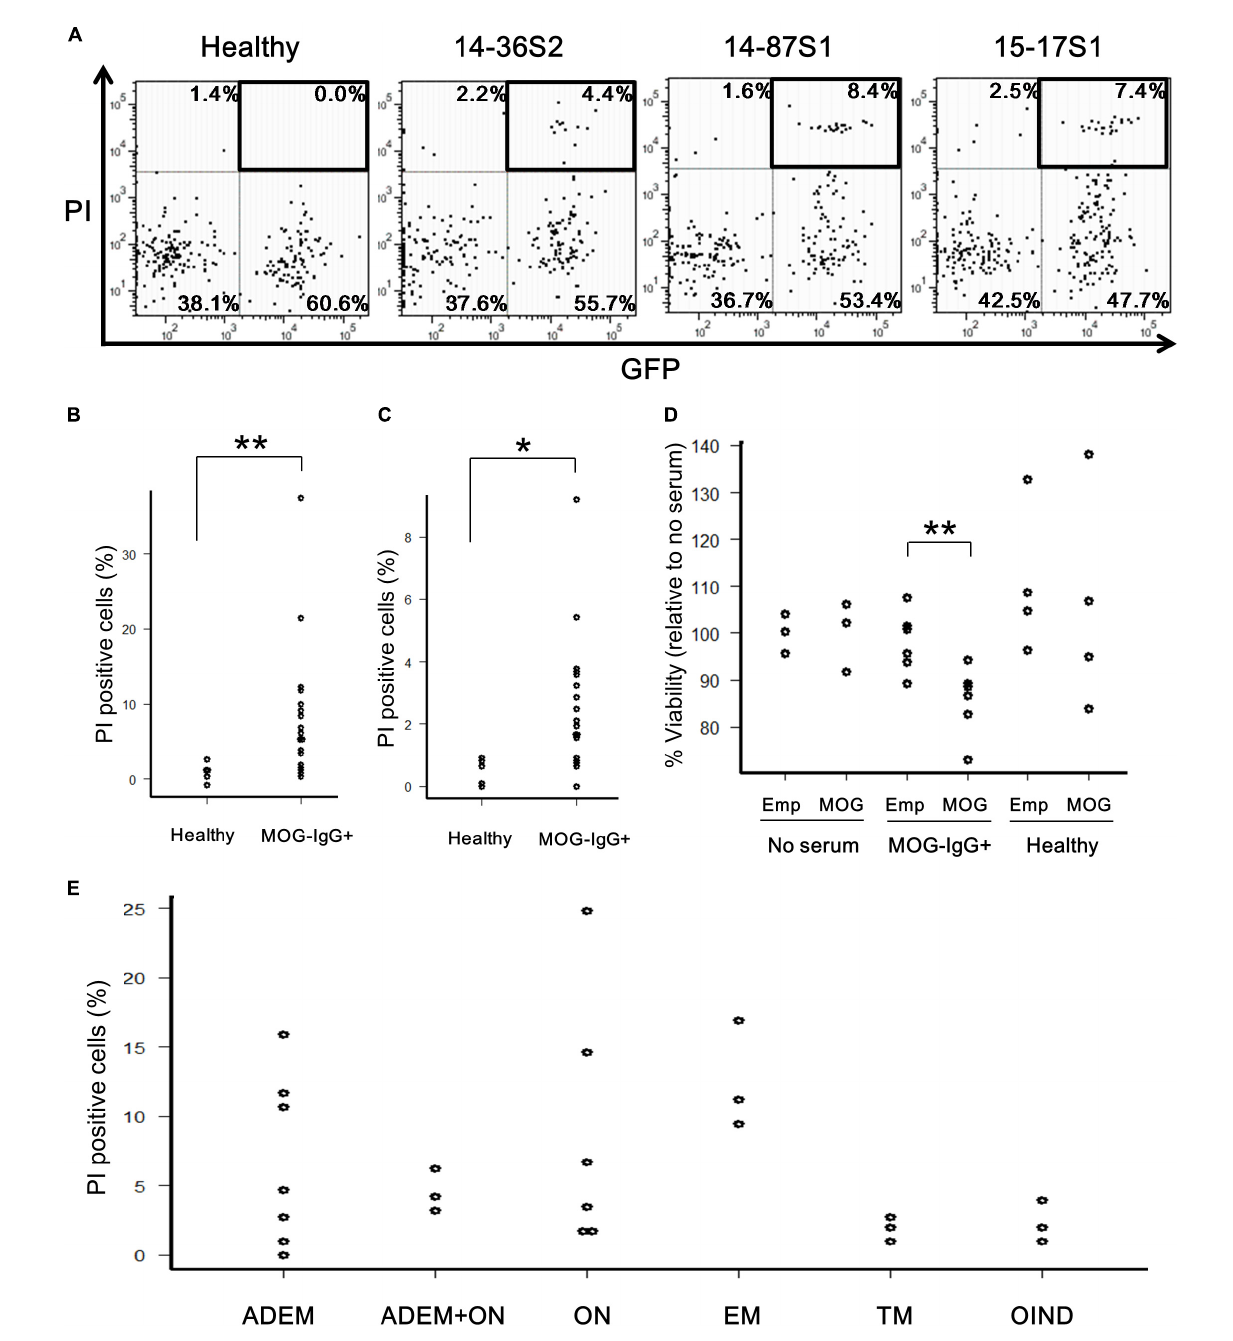
complement and observed by immunofluorescence (IF) to examine the formation of the membrane attack complex. Both IgG and C9 were detected on the MOG-GFP cell surface when reacted with